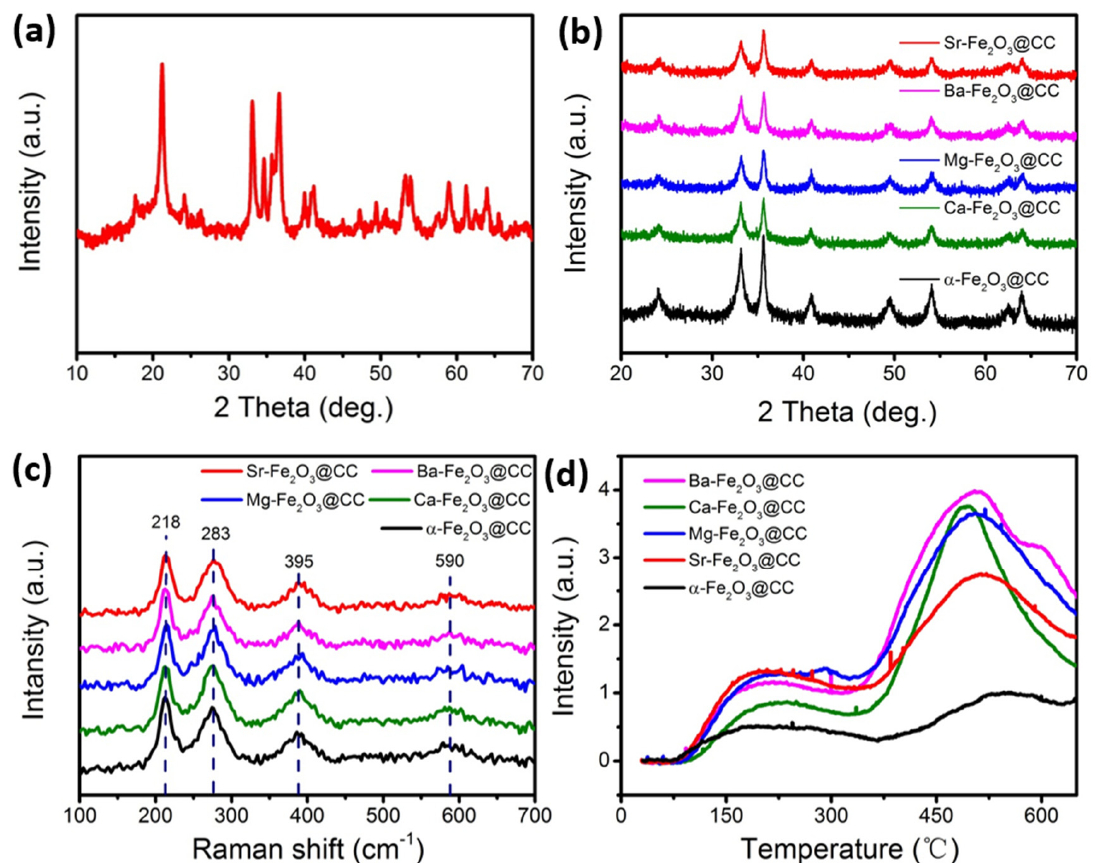
Figure 2. ( a ) XRD patterns for FeOOH. ( b ) XRD patterns, ( c ) Raman spectra, and ( d ) O 2 -TPD patterns for α -Fe 2 O 3 @CC, Sr-Fe 2 O 3 @CC, Ba-Fe 2 O 3 @CC, Mg-Fe 2 O 3 @CC, and Ca-Fe 2 O 3 @CC.